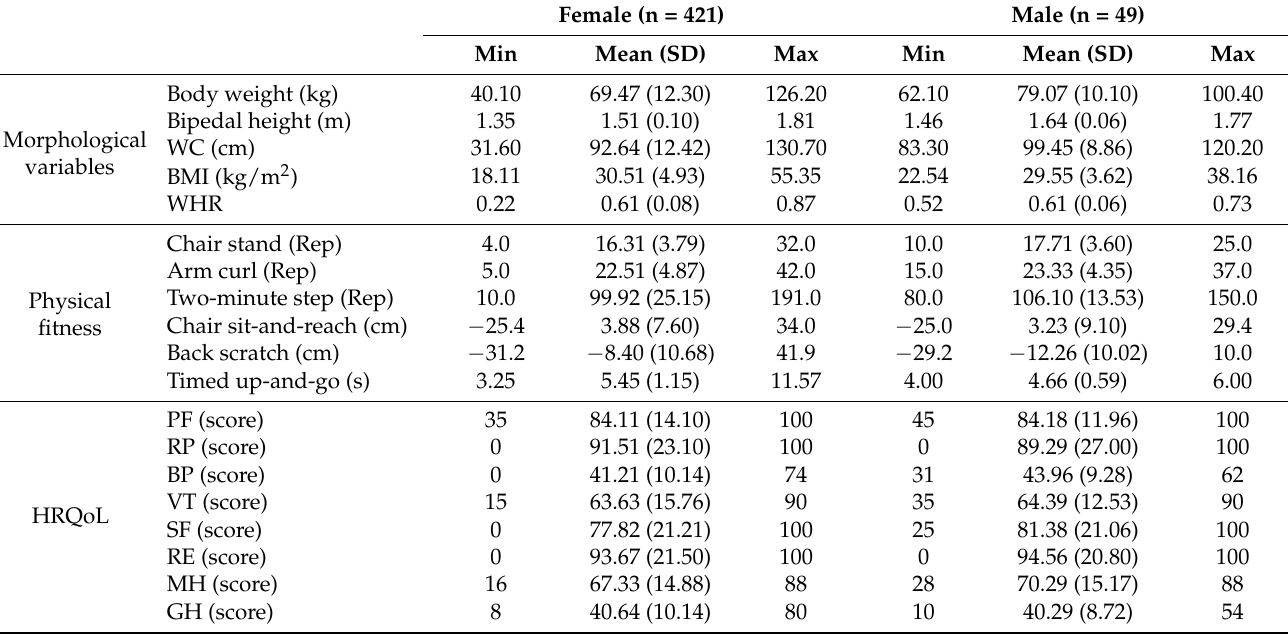
Table 1. Characteristics of the